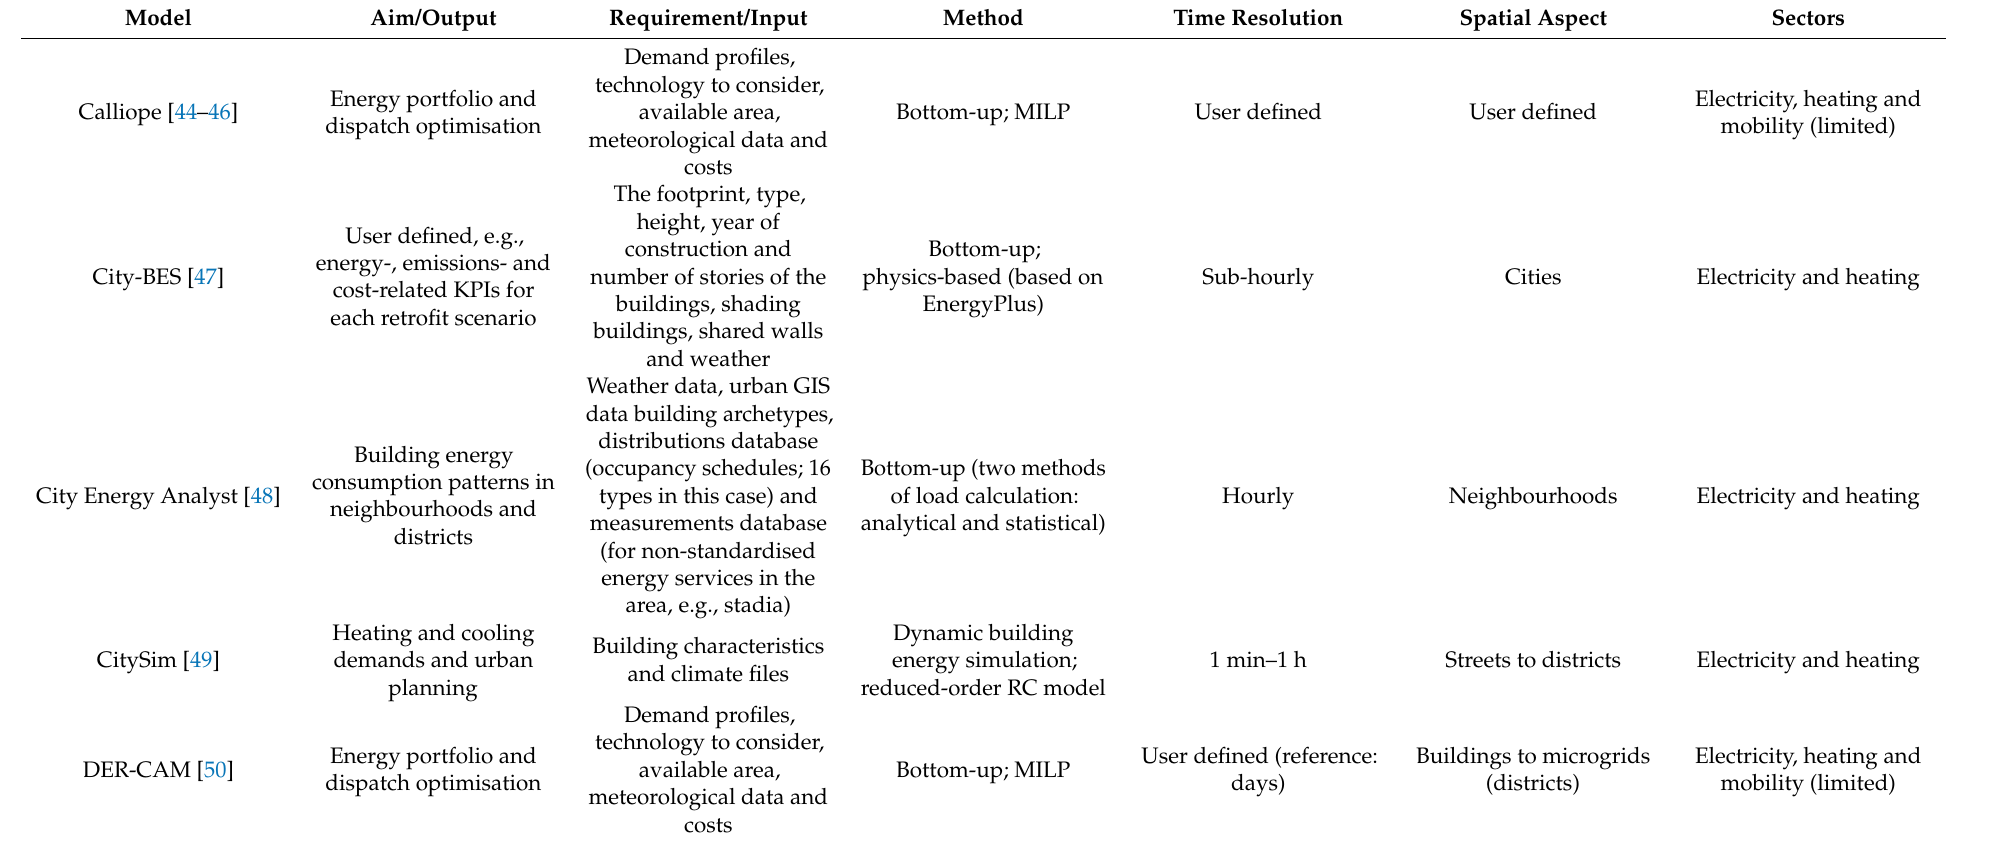
Table A1. A list of the reviewed